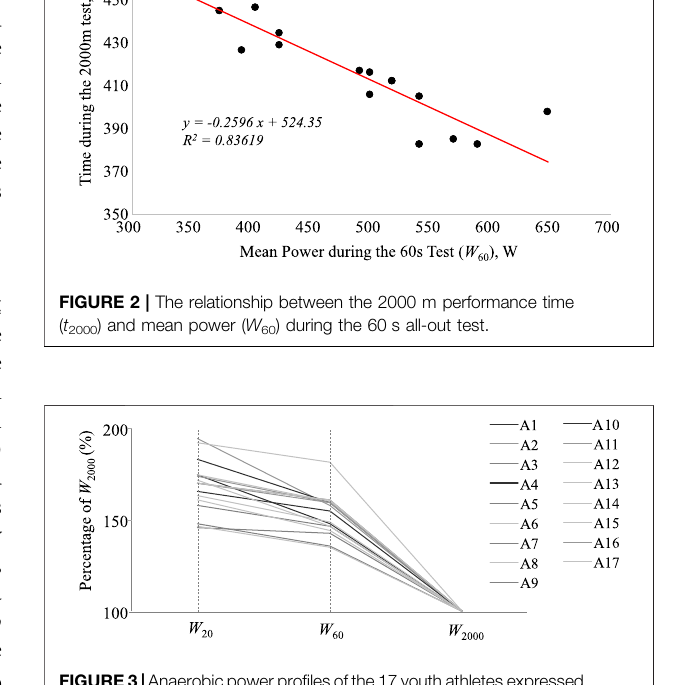
FIGURE3| Anaerobicpowerpro fi lesofthe17youthathletesexpressed through the percentages of the mean power W 20 and W 60 during the 20 and 60s tests with respect to the 2000m actual